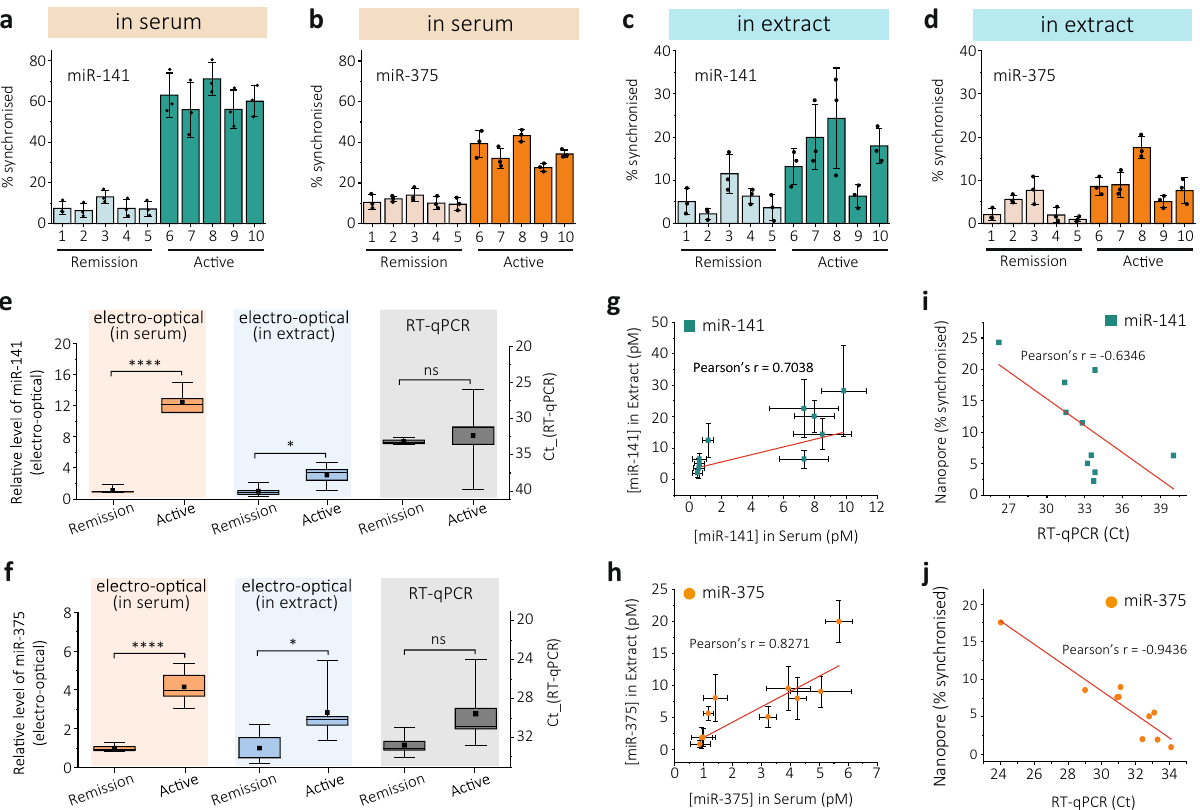
Fig. 5 miRNA pro fi ling of prostate cancer patients. a – d Synchronisation ratio of miR-141-3p and miR-375-3p for patients in remission ( n = 5) and patients with active prostate cancer ( n = 5) detected directly from serum ( a , b ) and in RNA extracted from serum ( c , d ). Error bars represent 1 × σ obtained from 3 different nanopore measurements ( n = 3). e , f Box plots of relative expression levels for miR-141-3p ( e ) and miR-375-3p ( f ) for patients in remission and with active cancer detected directly from serum, RNA extract and RT-qPCR (remission: n = 5; active: n = 5), respectively. For all boxes, the black central line represents the median, the square represents the mean, the bottom and top edges mark the 25th and 75th percentiles. The whiskers denote the intervals between 5th and 95th percentiles. Statistical signi fi cance was tested using two-tailed Student ’ s t -test. For miR-141-3p, **** P < 0.0001; * P = 0.0166; ns, not signi fi cant, P = 0.724. For miR-375-3p, **** P < 0.0001; * P = 0.0488; ns, not signi fi cant, P = 0.079. g , h Correlation between expression values measured in serum and in extracts for miR-141-3p ( g ) and miR-375-3p ( h ). Pearson ’ s r for miR-141-3p, r = 0.7038, P = 0.0231, and for miR-375-3p, r = 0.8217, P = 0.0035. Concentrations of miRNAs were calculated from the calibration curves in Fig. 4 and Supplementary Fig. 11. The error bars represent 1 × σ obtained from 3 different nanopore measurements ( n = 3). i , j Correlation between % synchronised measured in extracts and Ct value measured using RT-qPCR for miR-141-3p ( i ) and miR-375-3p ( j ), respectively. Pearson ’ s r for miR-141-3p, r = − 0.6346, P = 0.0485, and for miR-375-3p, r = − 0.9436, P = 0.0001. Statistical signi fi cance in g – j were tested using two-tailed Student ’ s t